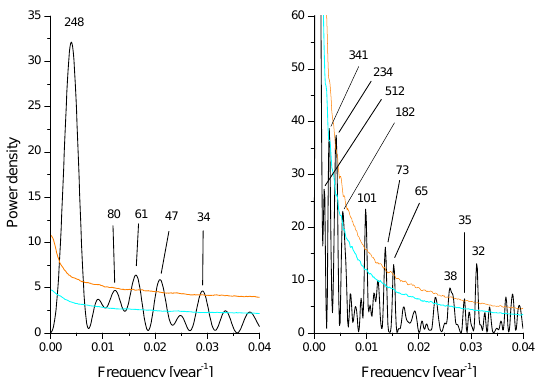
Fig. 4. Temporal picture of the ∼ 235yr frequency component of SPA (sinusoid, blue) together with SM6 (black), showing an ap- proximate matching of the phases.